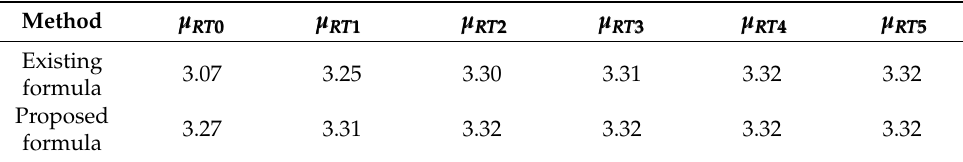
Table 2. Convergence of the existing formula and the proposed formula.